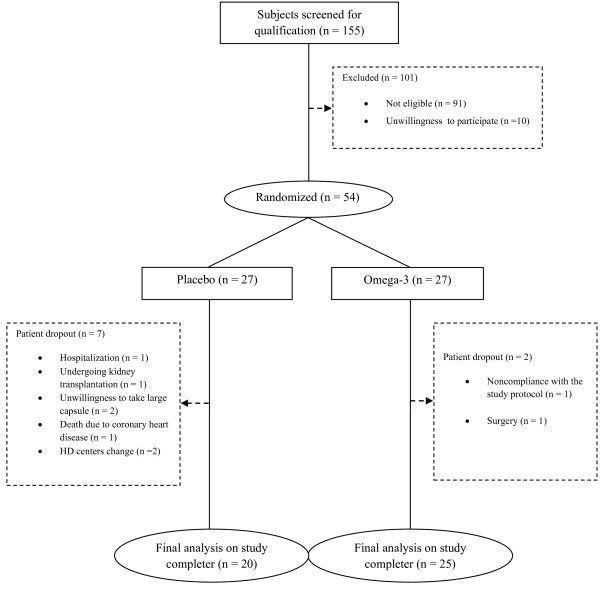
Study’s flowchart indicating patient randomization and participation.